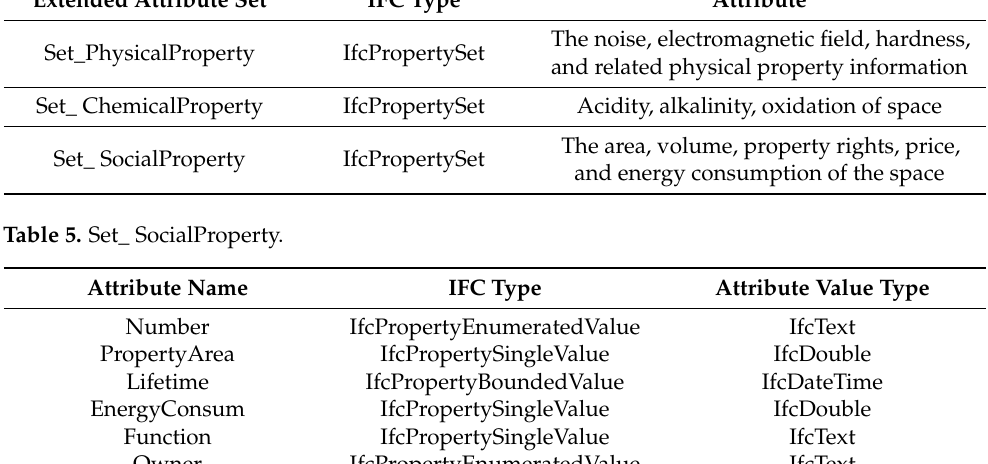
Table 4. Definition of the attribute set of indoor space.